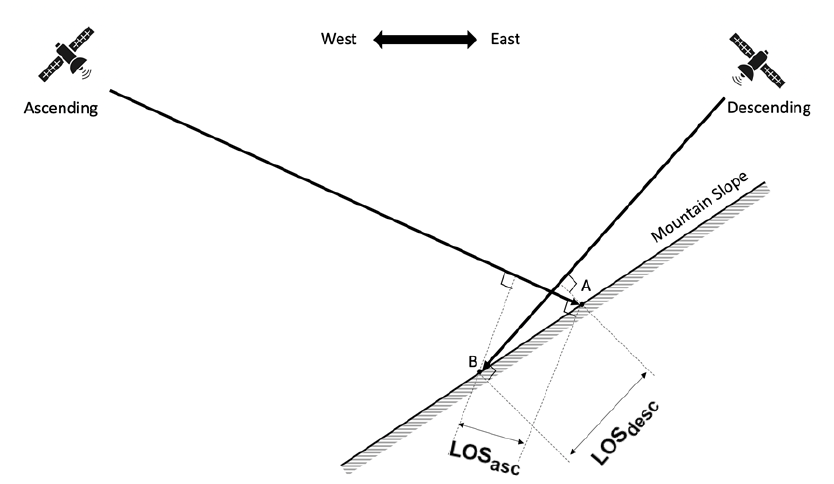
Figure 5. Line-of-sight (LOS) motion on a west-facing slope viewed from opposing geometries. Should point A move downslope to point B between acquisitions, the ascending data would register a decrease in distance by an amount LOS asc whereas the descending data would identify an increase of LOS desc . Owing to the imaging geometry, LOS asc < LOS desc meaning that the descending data is much more sensitive to changes.